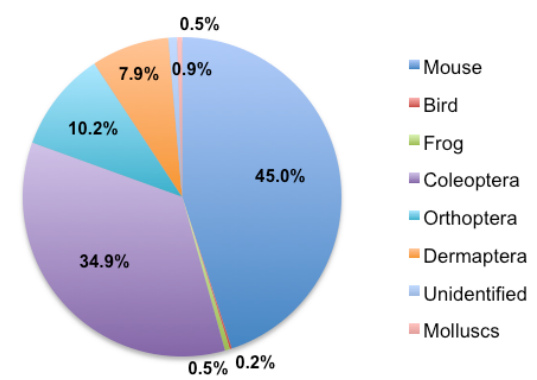
Figure 3. Percent prey composition in pellets of Spotted Owlet at all the eight